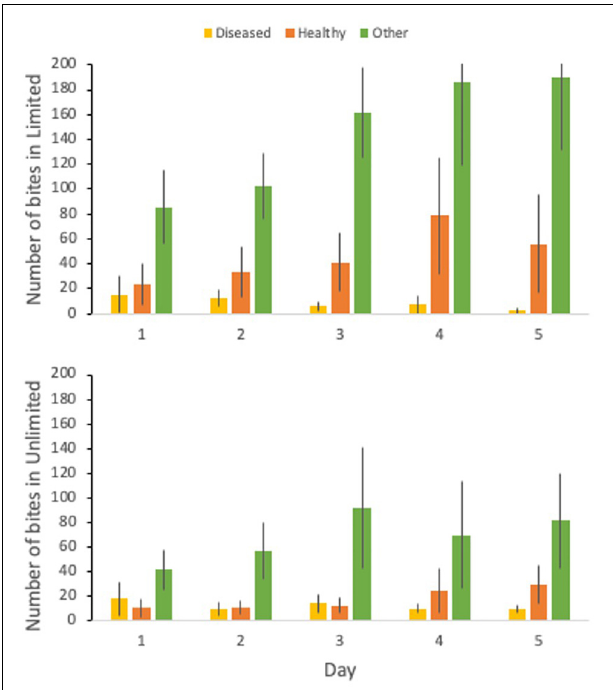
FIGURE 3 | The number of bites taken by C. capistratus on the diseased coral (yellow), healthy coral (orange), and elsewhere in the tank (green) for the 5-day trial for the limited (top) and unlimited (bottom)